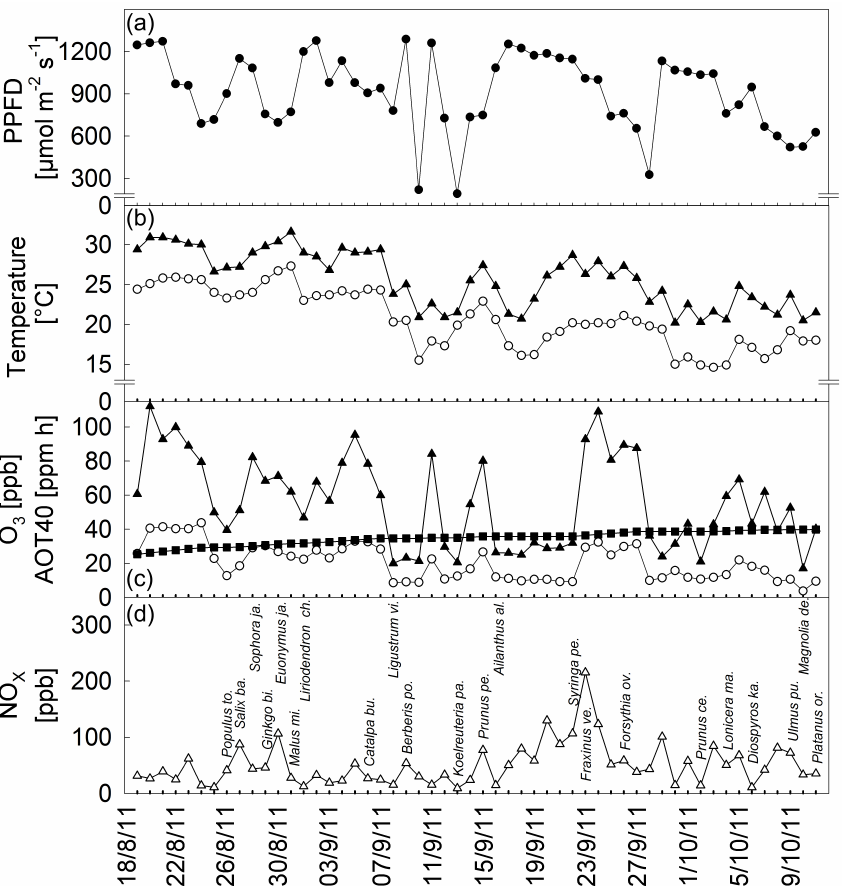
Figure 2. Climate data during the BVOC field campaign (August–October 2011) at an 8m height. (a) Photosynthetic photon flux density (PPFD), daily means (black circles); (b) air temperature, daily means (white circles), daily maximum (black triangles); (c) ozone, daily means (white circles), daily maximum (black triangles) AOT40 (calculated from beginning of July, black rectangles); (d) NO x (NO + NO 2 ) , daily means (white triangles). The sampling time of each plant species is given along the x